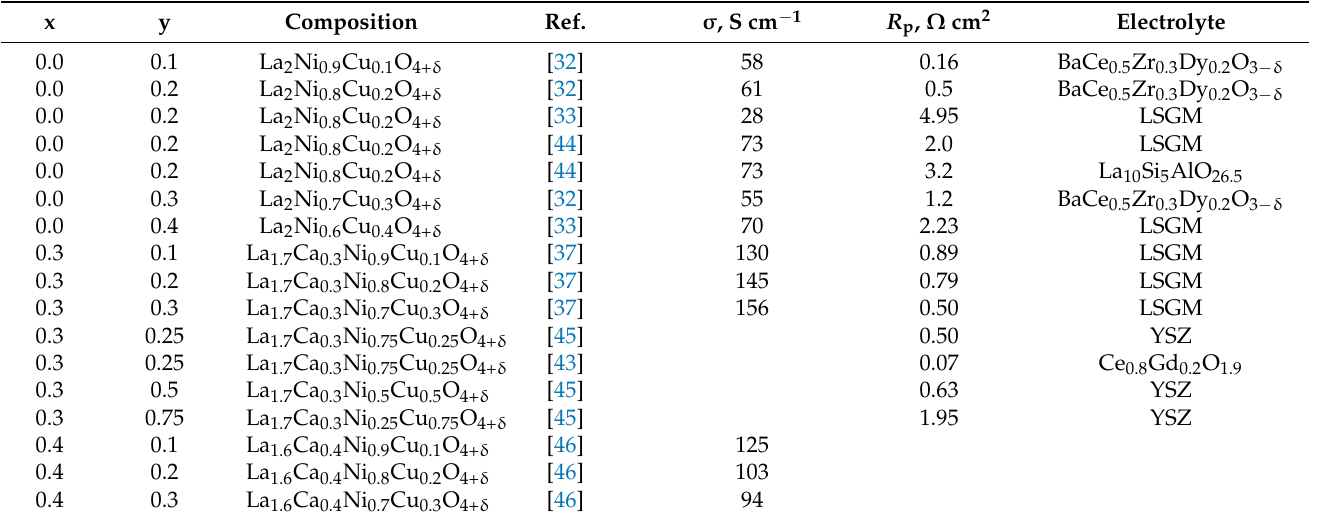
Table 2. Total conductivity and electrode polarization resistance of La 2 − x Ca x NiO 4+ δ nickelates at 700 ◦ C on Cu content